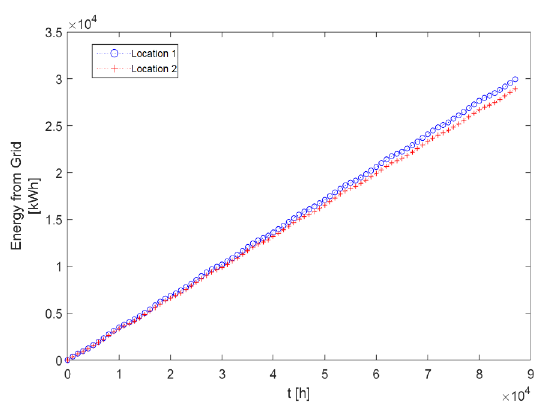
Figure 10. Energy from the grid (PV with battery).